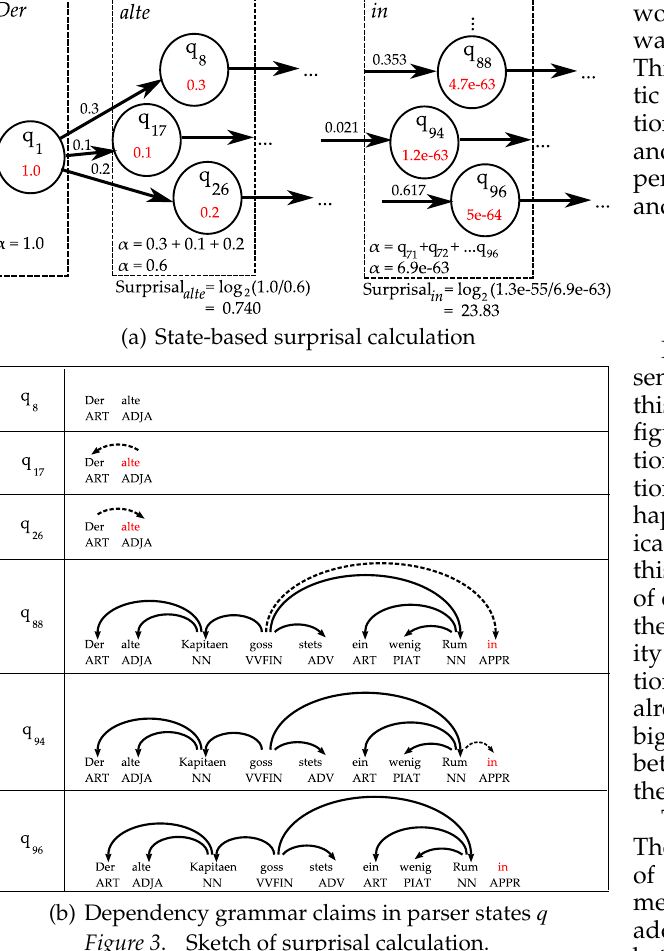
Figure 3 . Sketch of surprisal